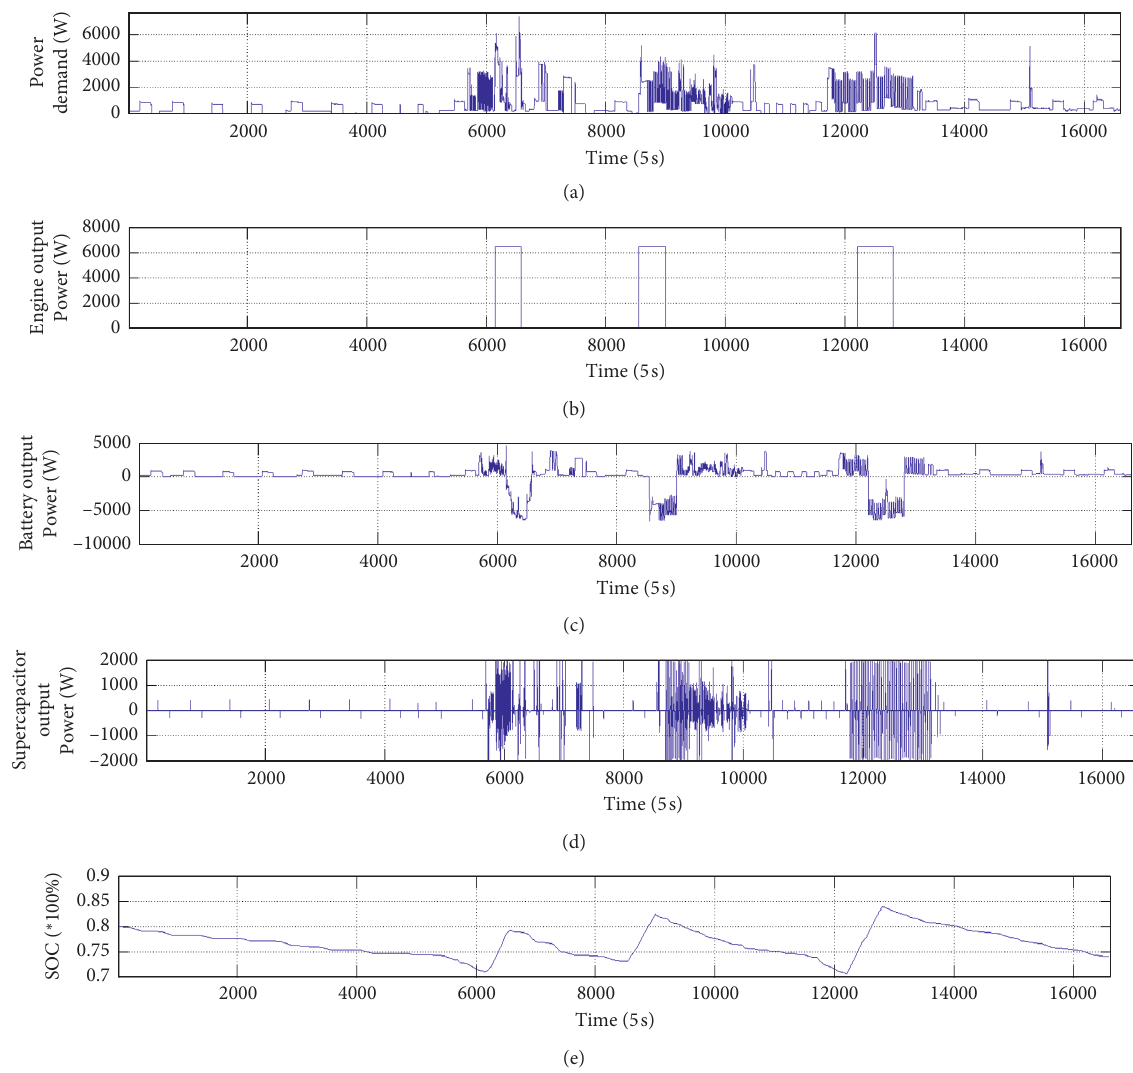
Figure 7: High-resolution simulation of the electrical energy supplying. (a) Electrical energy demand, (b) engine operation period, (c) batteries charging/discharging, (d) supercapacitor charging/discharging, and (e) the tracking of batteries’